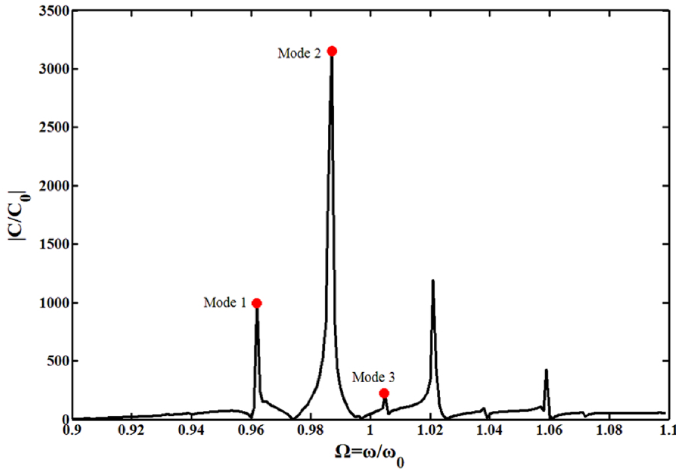
Figure 3. Normalized capacitance with respect to diving frequency showing resonance modes.